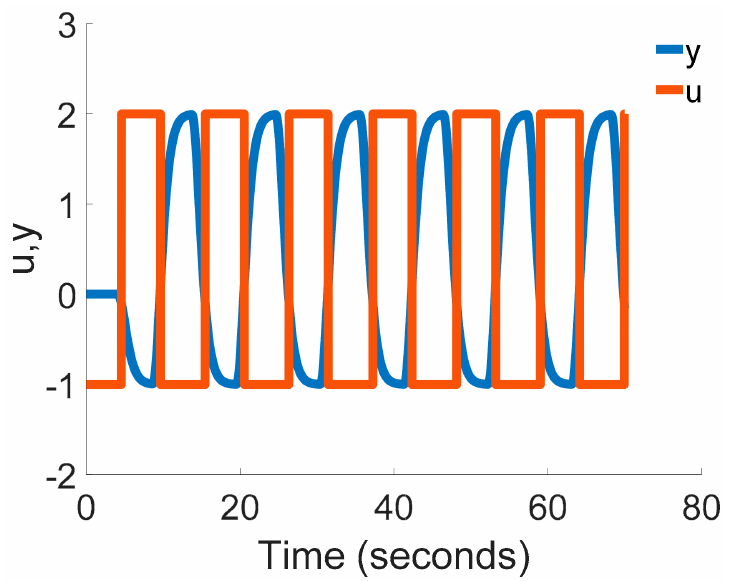
Figure 14. The relay output u and the observed output y of the process P 3 ( s